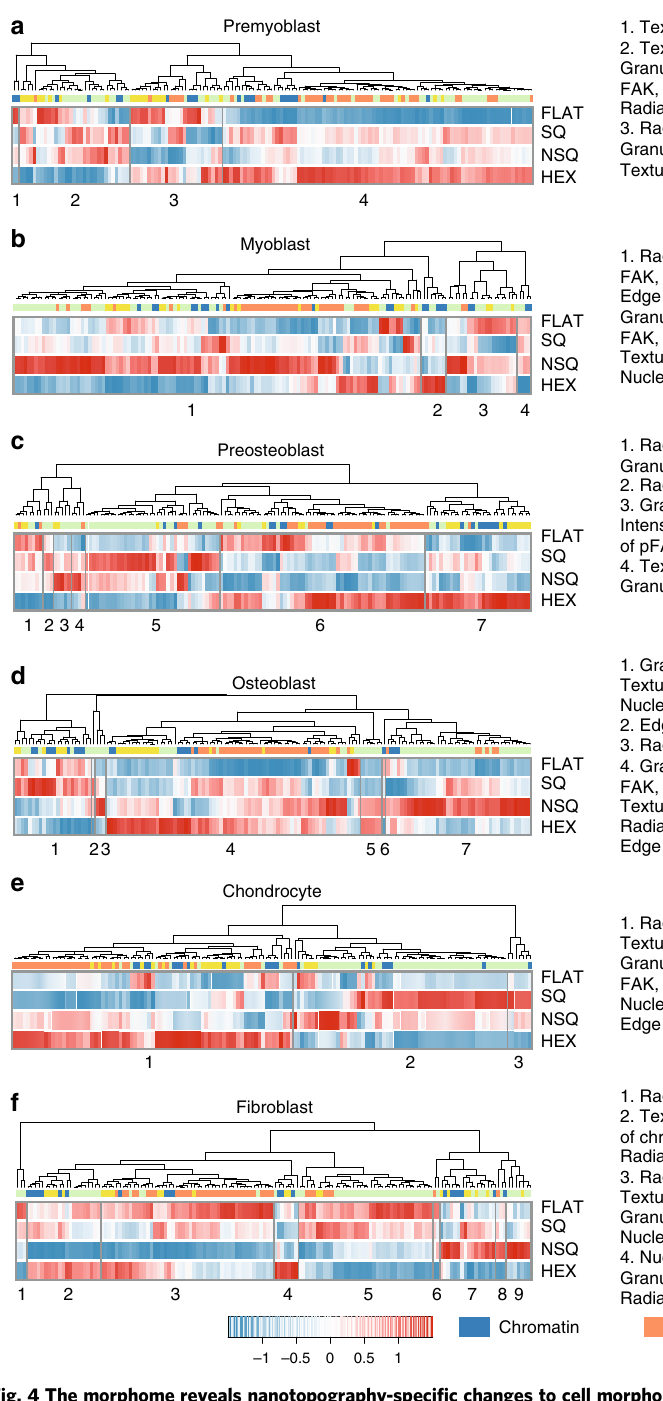
Fig. 4 The morphome reveals nanotopography-speci fi c changes to cell morphology. Hierarchical clustering of the morphome within each cell type. The data morphome from each cell type were clustered separately (see Supplementary Data 5). Within the cell type-speci fi c morphome, each morphome feature was normalized to have a mean = 0 and standard deviation = 1. The color and intensity of each tile represents the average value of the feature. The morphome features analyzed were comprises 21 chromatin, 42 actin, 23 FAK, and 60 pFAK features. Features included were changed signi fi cantly across topographies ( p < 0.05 using one-way ANOVA). The total number of cells analyzed from two independent experiments were: a n = 877 pre-myoblasts; b n = 931 myoblasts; c n = 644 pre-osteoblasts; d n = 728 osteoblasts; e n = 619 chondrocytes; and f n = 1140 fi value for chromatin granularity and nuclear morphometry, and values of: focal adhesion textures, pFAK radial distribution, near-zero values for radial distribution of actin and of focal nuclear morphometry, and chromatin textures (Fig. 4a). The adhesions (Fig. 4b). High-chromatin granularity observed for both morphome of pre-myoblasts cultured on SQ re fl ects the need for pre-myoblasts and myoblasts on SQ denotes chromatin hetero- FAK phosphorylation and preferential localization at stress fi ber geneity and condensation and transcriptional activity, which is edges, which is necessary for myotube differentiation 32,33 . In reportedly higher prior to myotube formation 34,35 . contrast, myoblasts on SQ showed a particularly high average